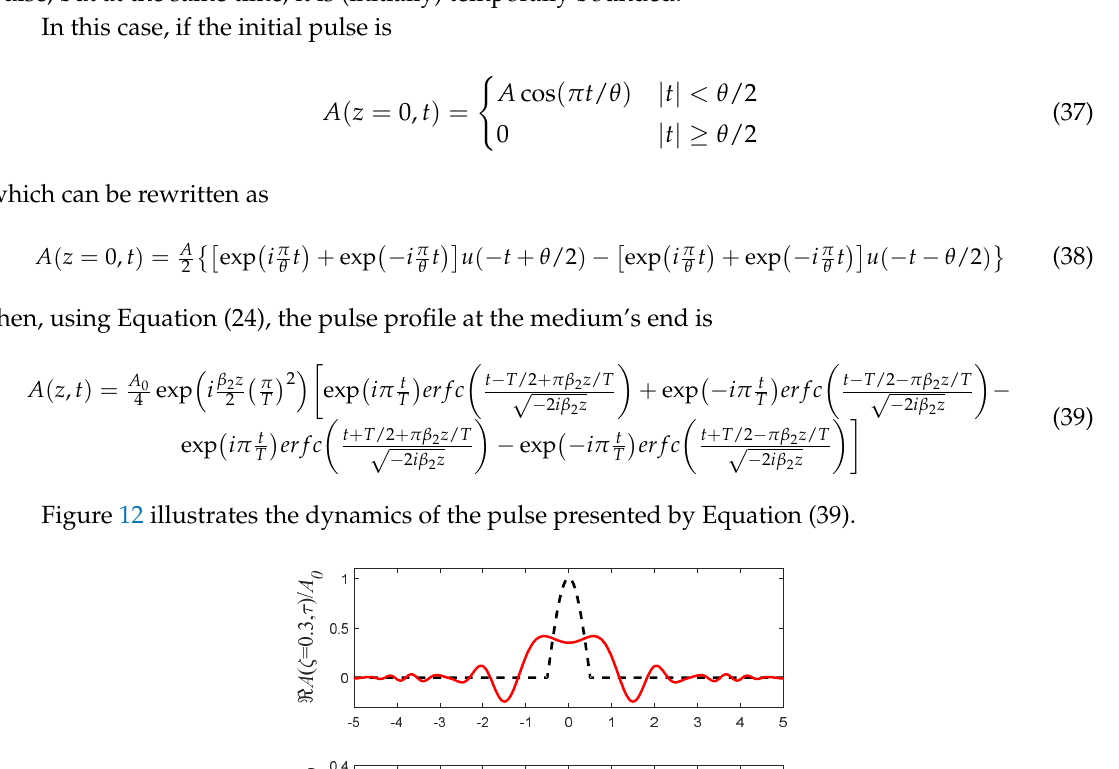
  2 , ztA ) of the pulse presented by Equation (36).